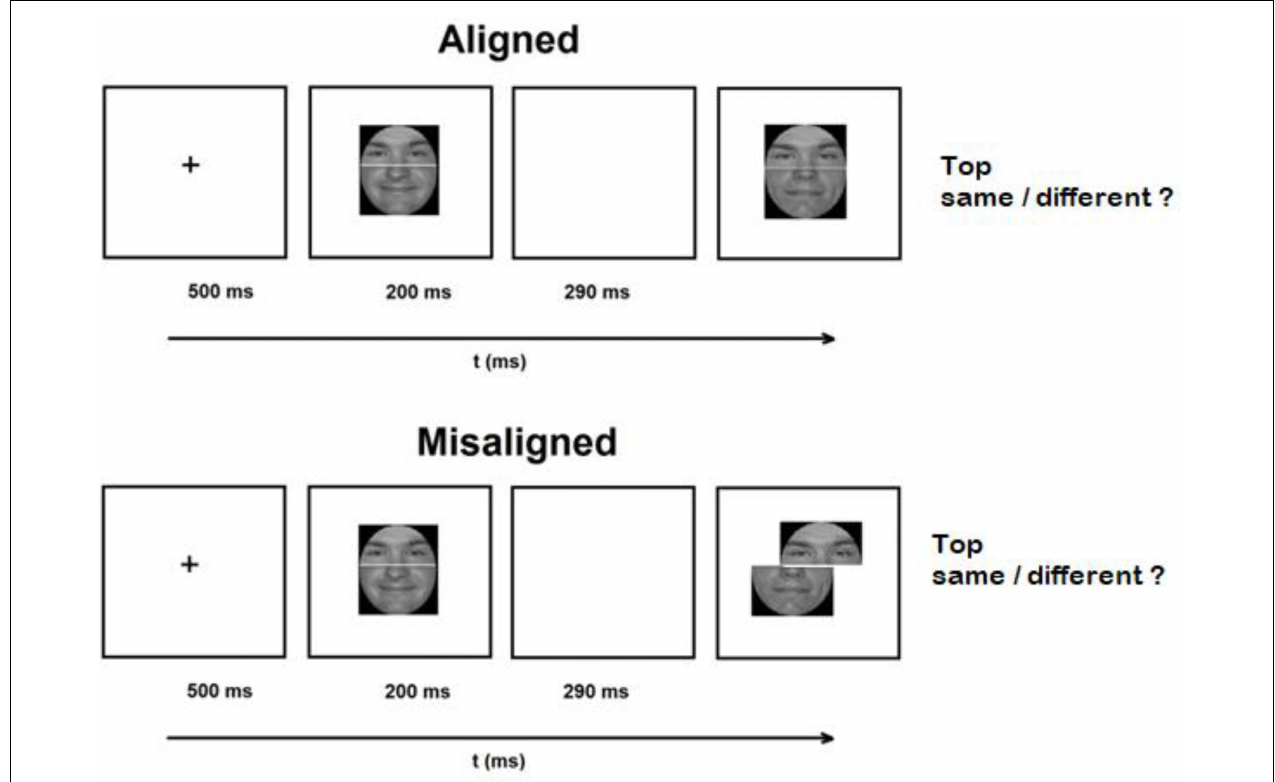
FIGURE 1 | An illustration of an experimental trial with unfamiliar aligned and misaligned composite